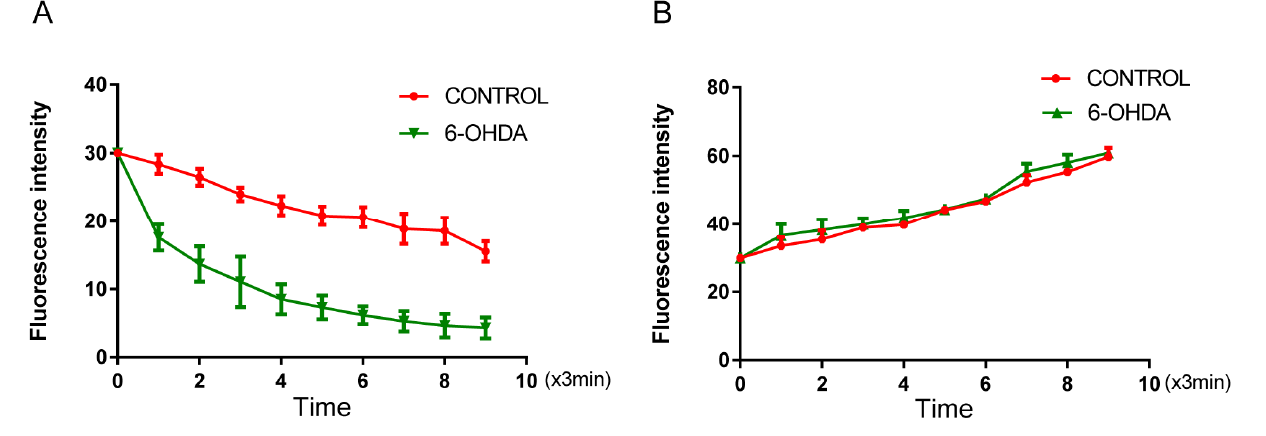
Figure 3. Modulation of iron trafficking in 6-OHDA-treated BV2 cells. ( A ) Calcein fluorescence was recorded at 488 nm excitation and 525 nm emission wavelengths and fluorescence intensity was measured every 3 min for 10 times while perfusing with 0.1 mM ferrous iron. For the iron efflux assay ( B ), primary cultured astrocytes were perfused with 1 mM ferrous iron for 20 min, then the fluorescence intensity was measured every 3 min for 10 times while perfusing with 1 mM DFO, a membrane-impermeant, strong and specific iron chelator, and the intracellular iron was drained out to the medium—indicated by the increase in calcein fluorescence. Data are presented as the mean ± SD of six independent experiments. n =